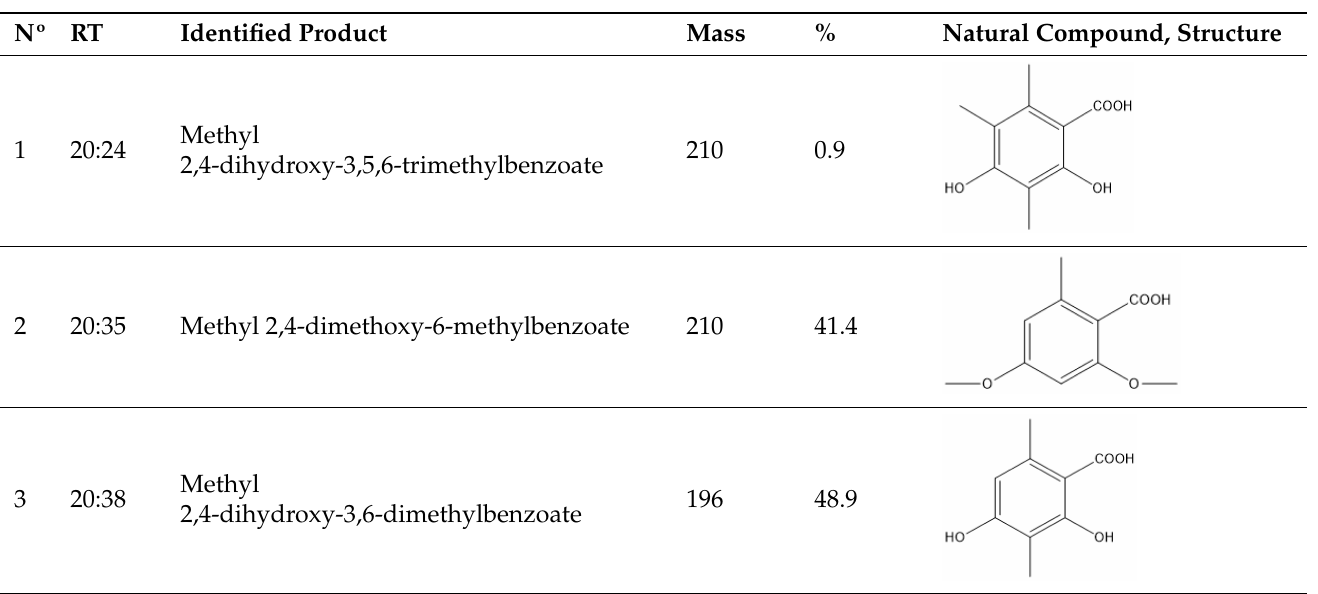
Figure 5. Chromatogram of Hexane extract part insoluble in MeOH esterified whit diazometane, 2-Cires . Table 4. Sample Parmotrema hypoleucinum (in Quercus coccifera ), Hexane extract part insoluble in MeOH esterified whit diazomethane, 2-Cires